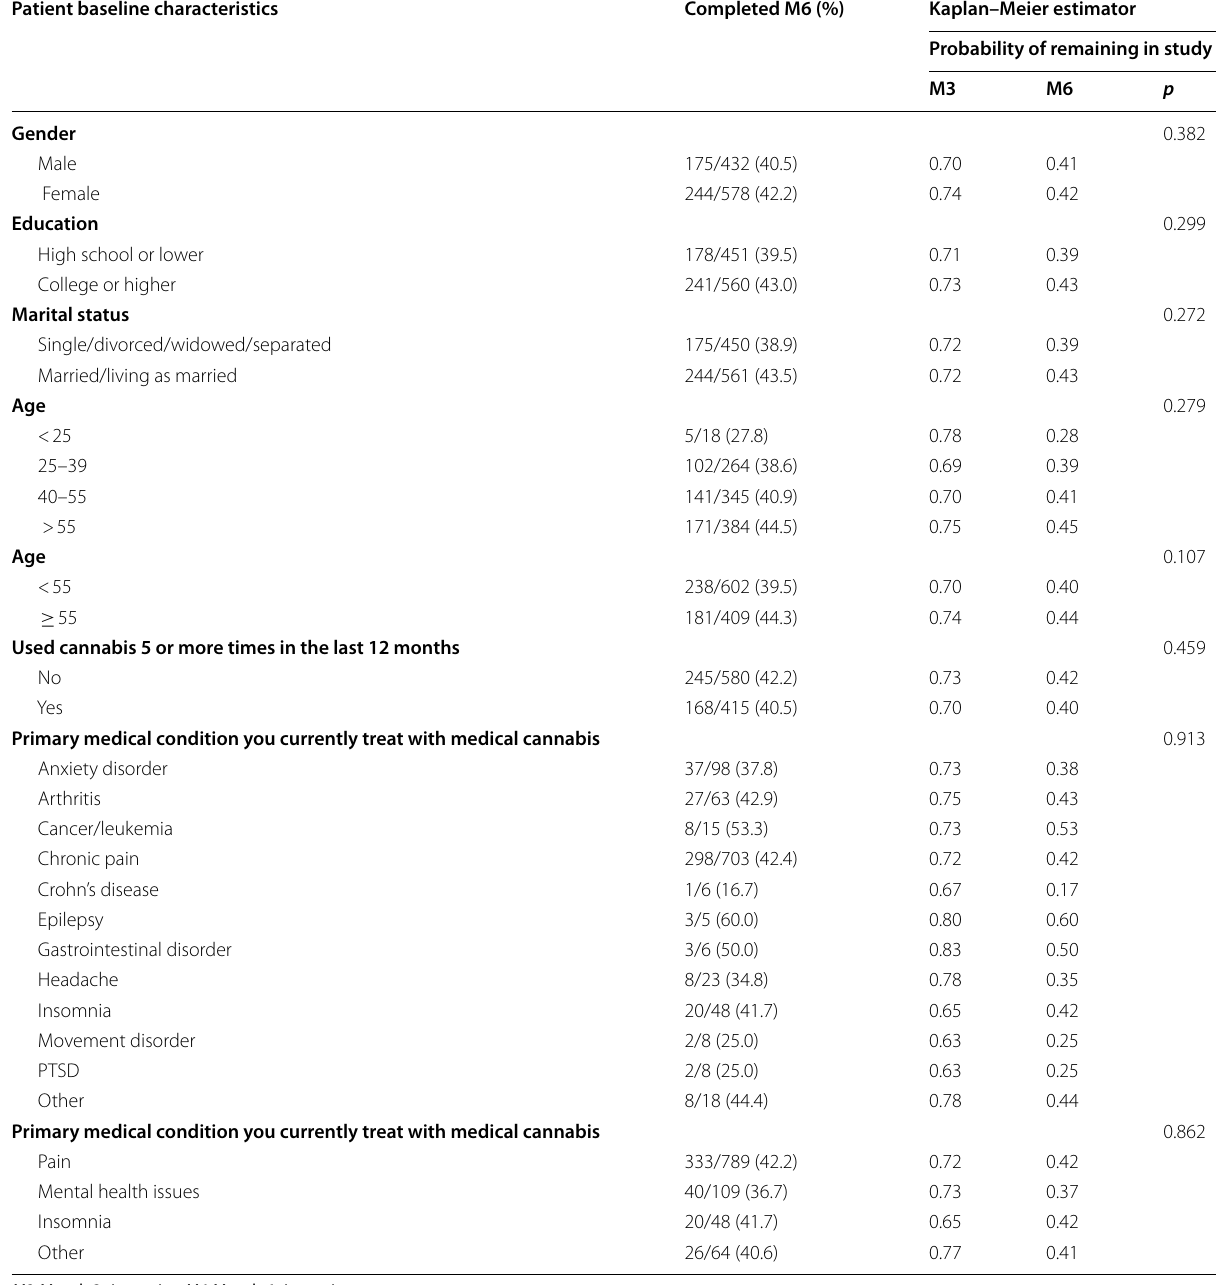
Table 1 Percent completing M6 and probability of retention at M3 and M6 by patient baseline characteristics and primary condition in 1011